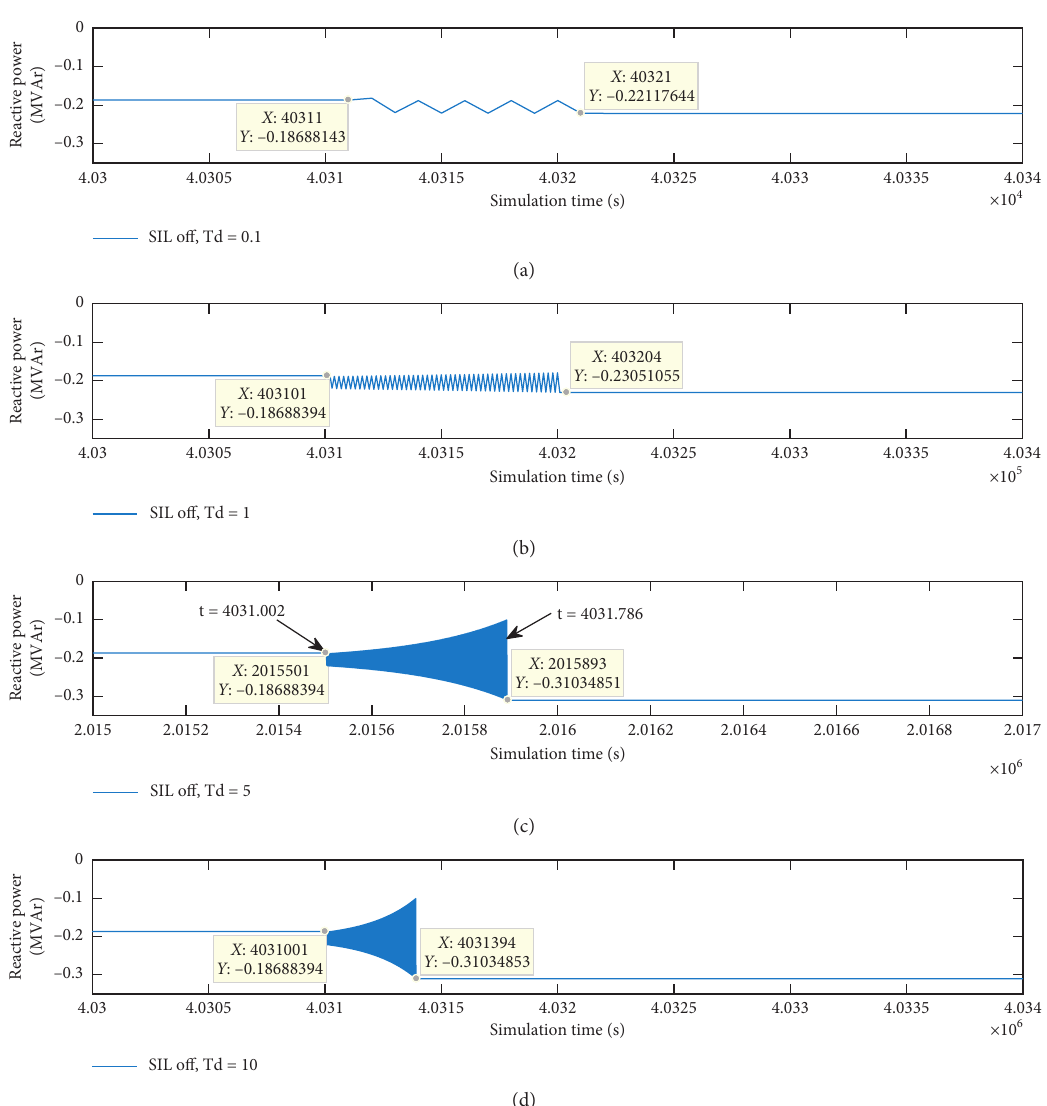
Figure 7: Results of the offline SIL simulations. Comparison of the reactive power of the WTconverter when T or 10, and T d � 4 or 5.